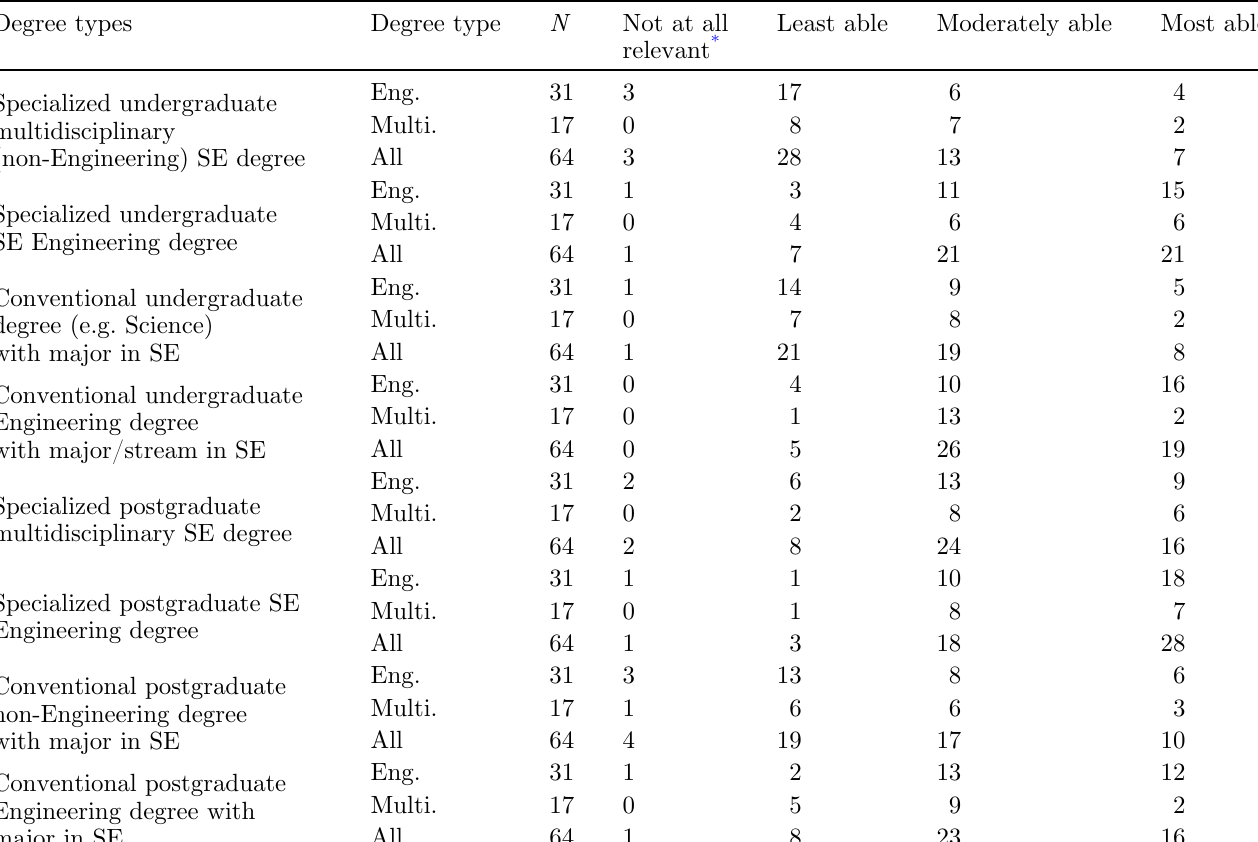
Table 3. Graduates ’ ratings of the ability of different types of University quali fi cations to prepare them for working in the sustainable energy